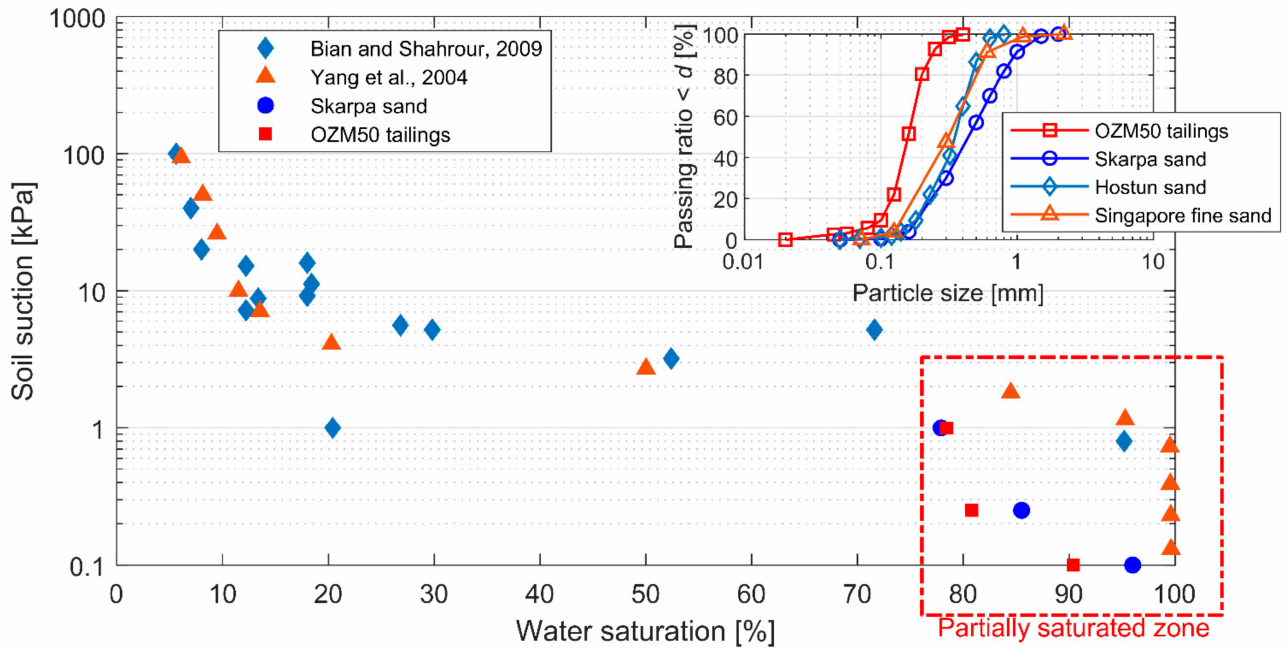
Figure 3. Suction pressures for tested soils and water retention curve for: Hostun sand [20] and Singapore fine sand